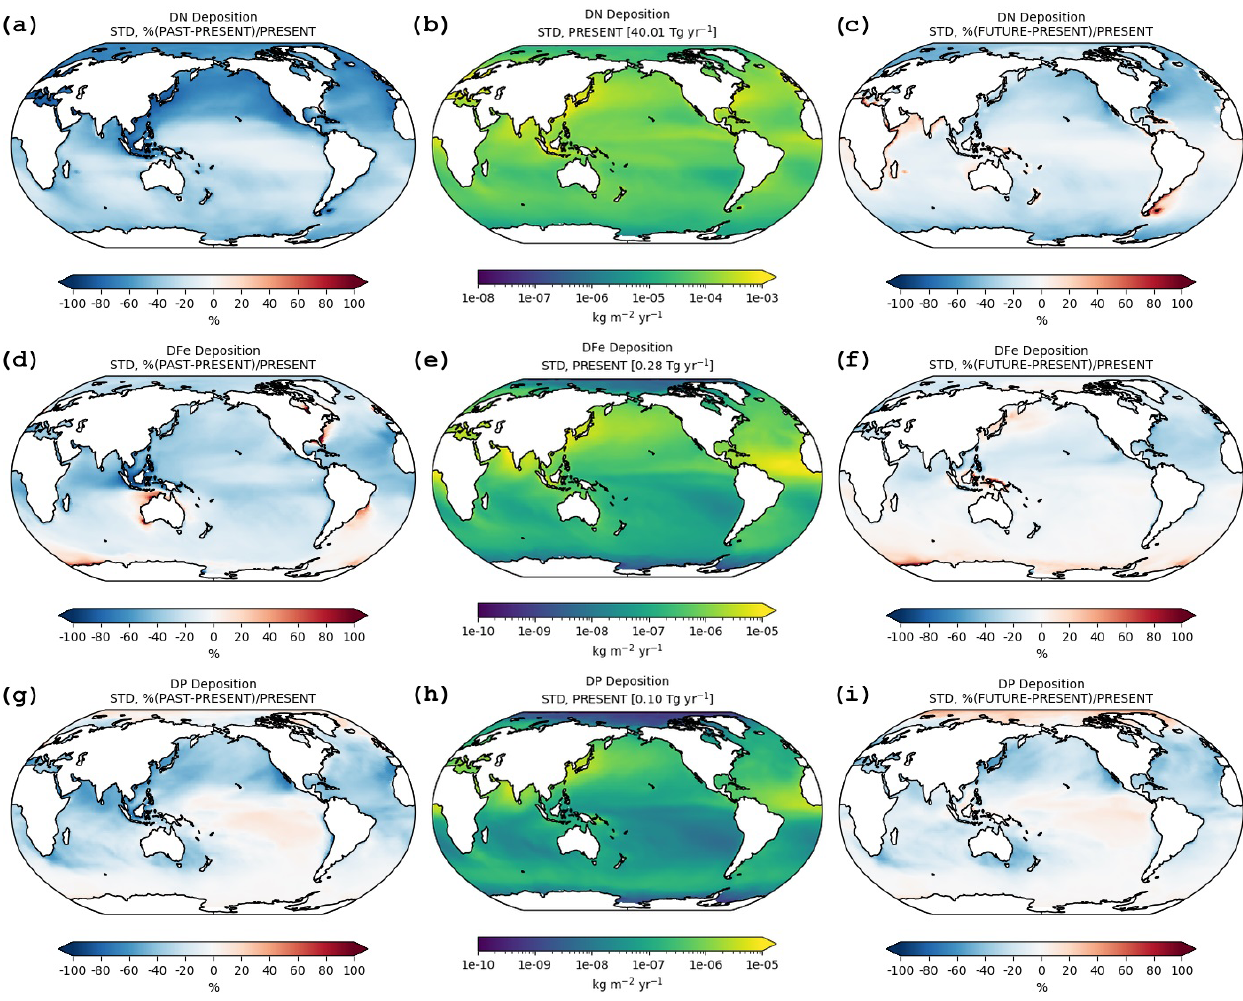
Figure 1. Atmospheric deposition fluxes into the ocean (kgm − 2 yr − 1 ) of dissolved nitrogen (b) , iron (e) , and phosphorus (h) considered by the model for PRESENT (b, e, h) for the STD simulation, and the respective relative differences (%) compared to PAST (a, d, g) and FUTURE (c, f, i)